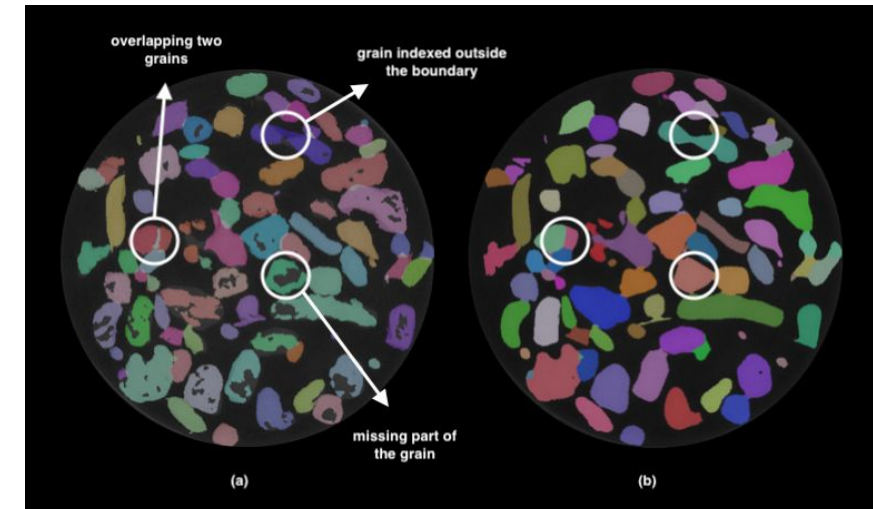
Figure 3. Effect of step 8 to improve the reconstruction quality: before (a) and after (b) correction.